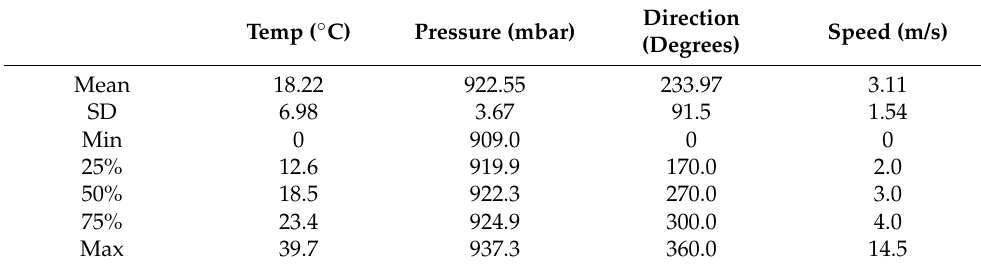
Table 2. Wind speed data analysis based on minimum, mean, max, SD, 25th, 50th, and 75th percentiles of the wind speed dataset.